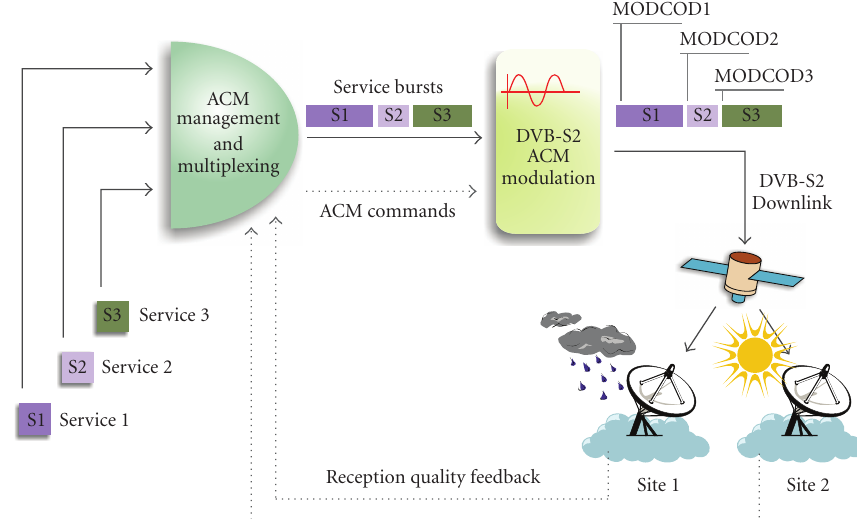
Figure 1: DVB-S2 adaptive coding and